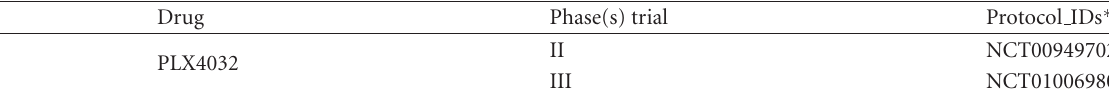
Table 6: Selected drugs for targeted melanoma therapy.